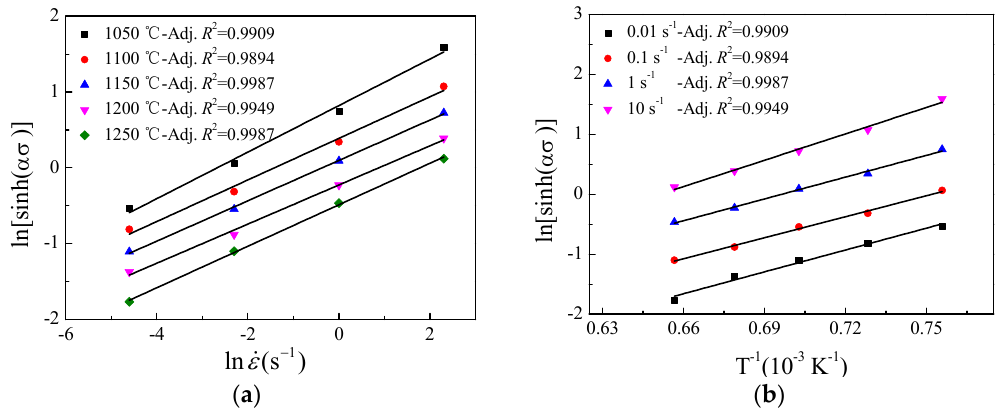
( a ) ( b ) . ε Figure 5. Relationships between: ( a ) ln(sinh( ))  and ln   ( b ) ln(sinh( ))  and 1/ T . Figure 5. Relationships between: ( a ) ln p sinh p ασ qq and ln ( b ) ln p sinh p ασ qq and 1 { T .